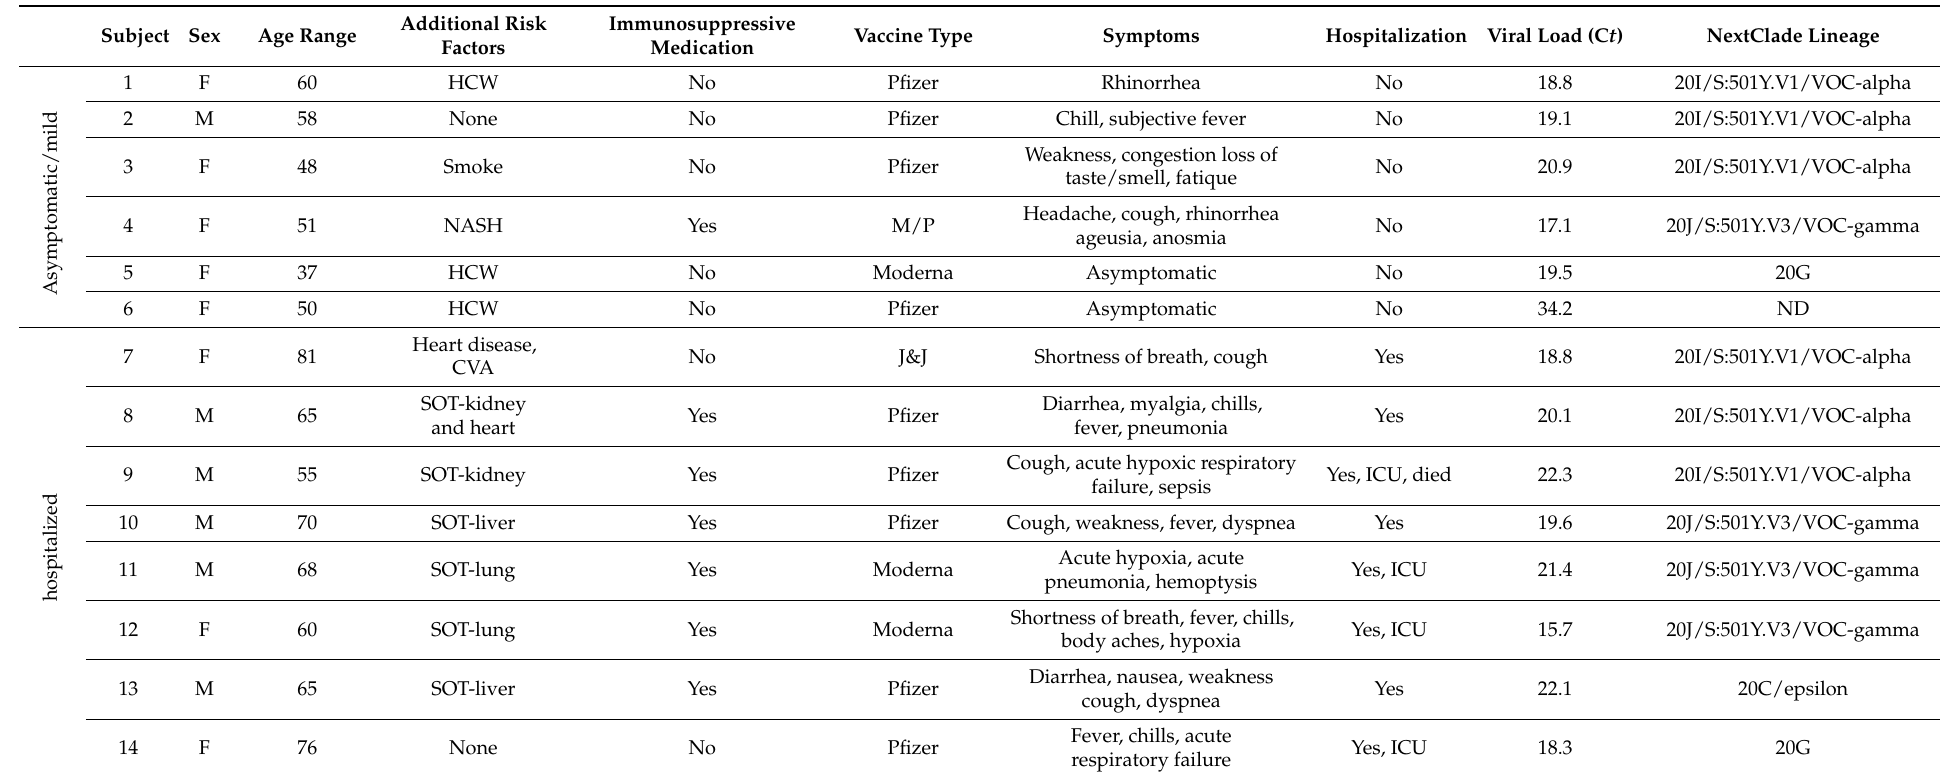
Table 1. Demographics of patients, clinical and virological